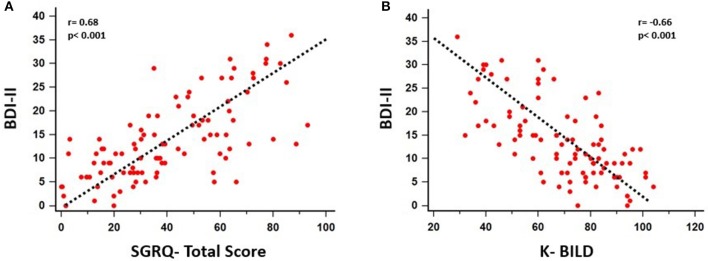
Significant association of depression with patients' quality of life as assessed by SGRQ (Total score: r = 0.68, p < 0.001, Activity Score: r = 0.60, p < 0.001, Impact score: r = 0.68, p < 0.001, Symptoms score: r = 0.60, p < 0.001) (A) and K-BILD (r = −0.66, p < 0.001) (B).